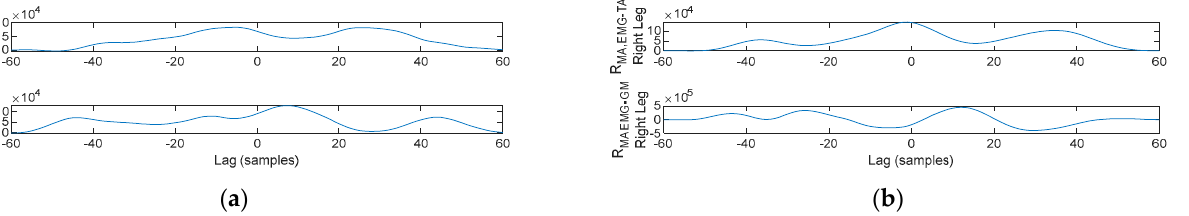
Figure 18. Cross-correlation of the MA and EMG signals plotted in Figure 17 for the ( a ) left foot and